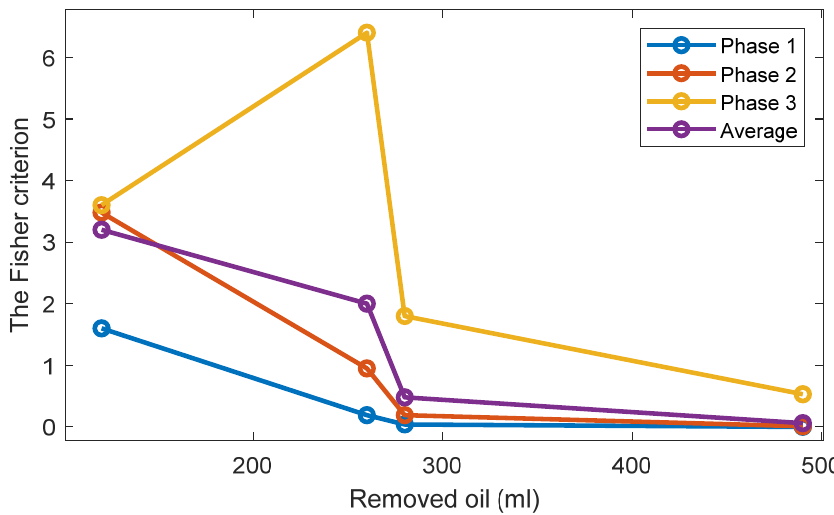
Figure A3. The FC of Feature 1 (the first harmonic of the supply frequency) for 3 phases and 4 levels of oil removal compared to the standard oil level (Day 2).